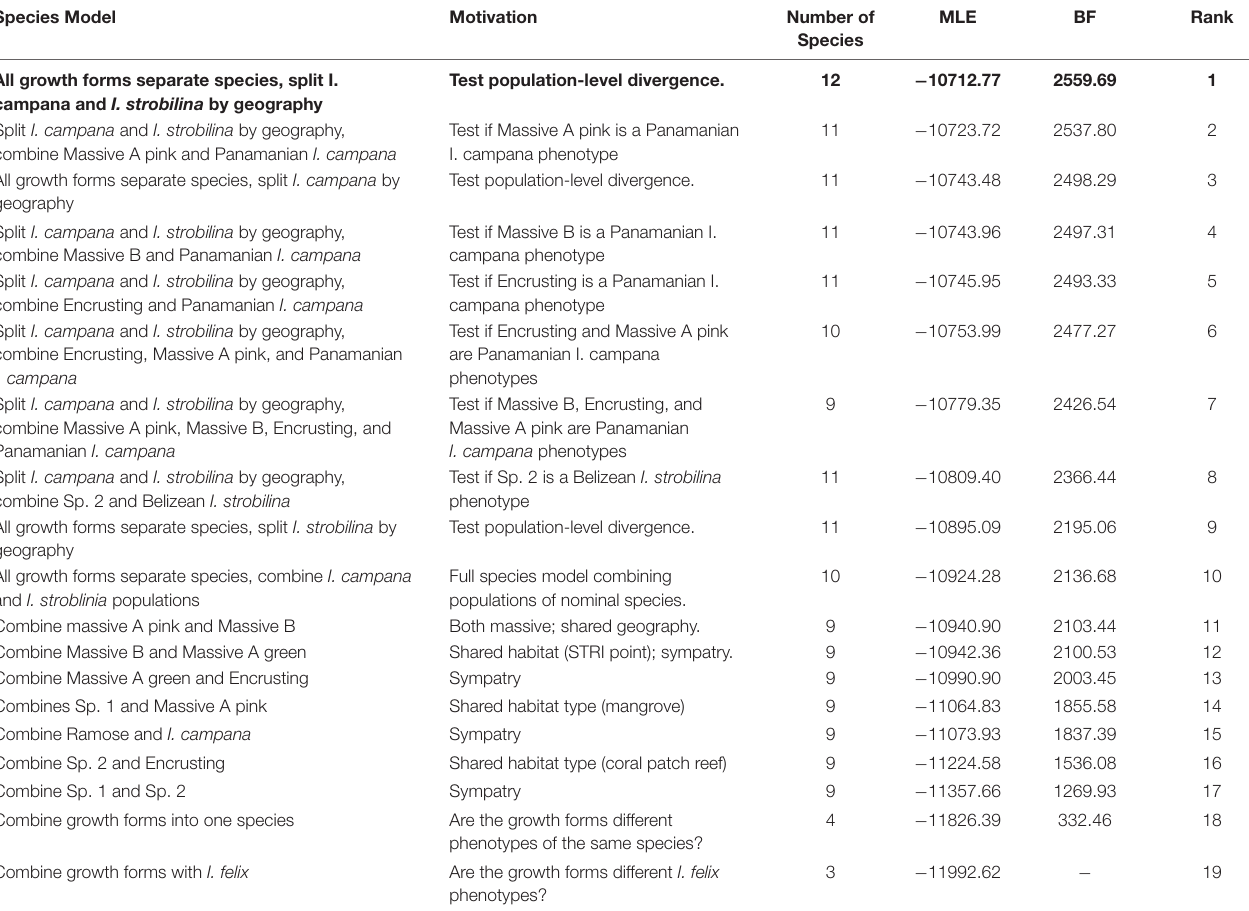
TABLE 1 | The species model representing each growth from and each population of nominal species as a distinct species (in bold letter face) received decisive support over competing models. Species Model Motivation Number of